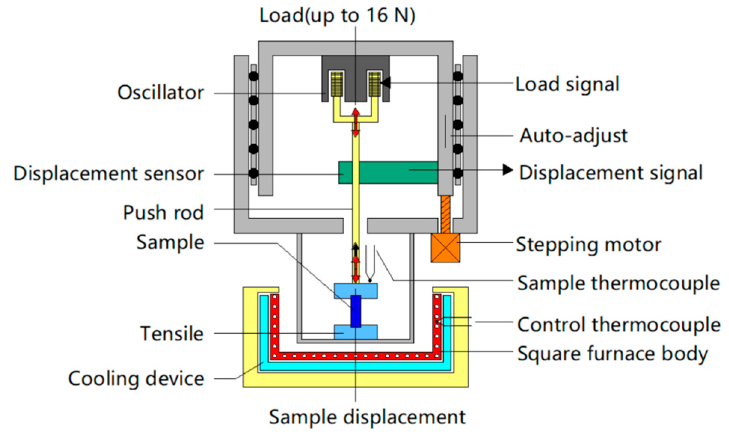
Figure 2. Dynamic thermomechanical analysis (DMA) tensile strain scanning with high precision.